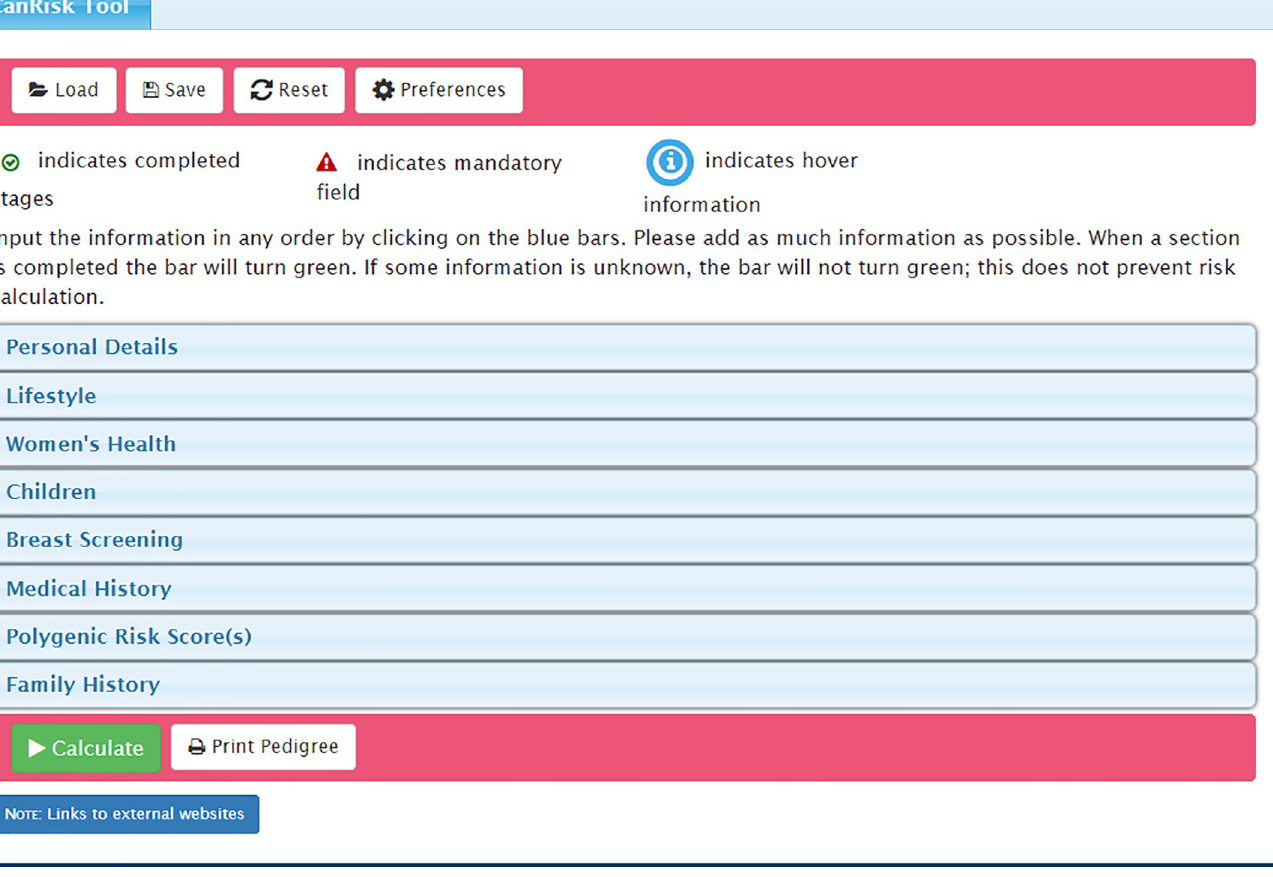
Fig 1. CanRisk tool initial page displaying the accordion menu of clinical topic areas included in the risk prediction calculation � . � image corresponds to the revised version of the tool (not the beta version